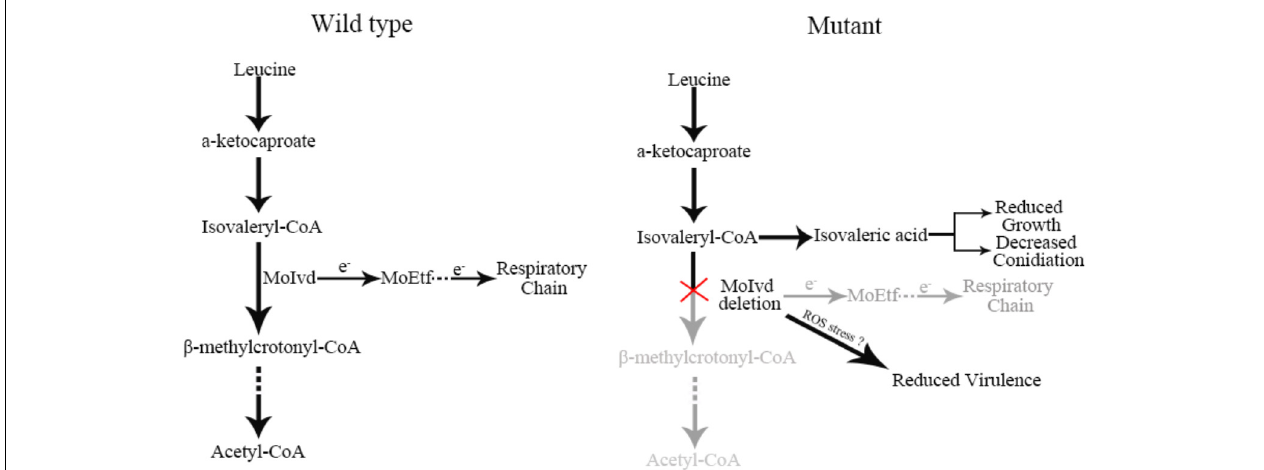
FIGURE 9 | Proposed working model of MoIVD in M. oryzae . In wild-type strain, leucine is normally degraded by the leucine catabolism pathway and electrons are transferred to the respiratory chain from MoIvd, while in the (cid:49) moivd mutants, the pathway was blocked at the third step where isovaleryl-CoA was converted into isovaleric acid. The isovaleric acid accumulation in mutant resulted in the reduced growth and decreased conidiation. The reduced virulence probably resulted from the mutant’s inability to overcome host ROS defense. “e − ” indicates electron. “?” means a probable virulence reduction mechanism of mutant not coping with ROS stress during